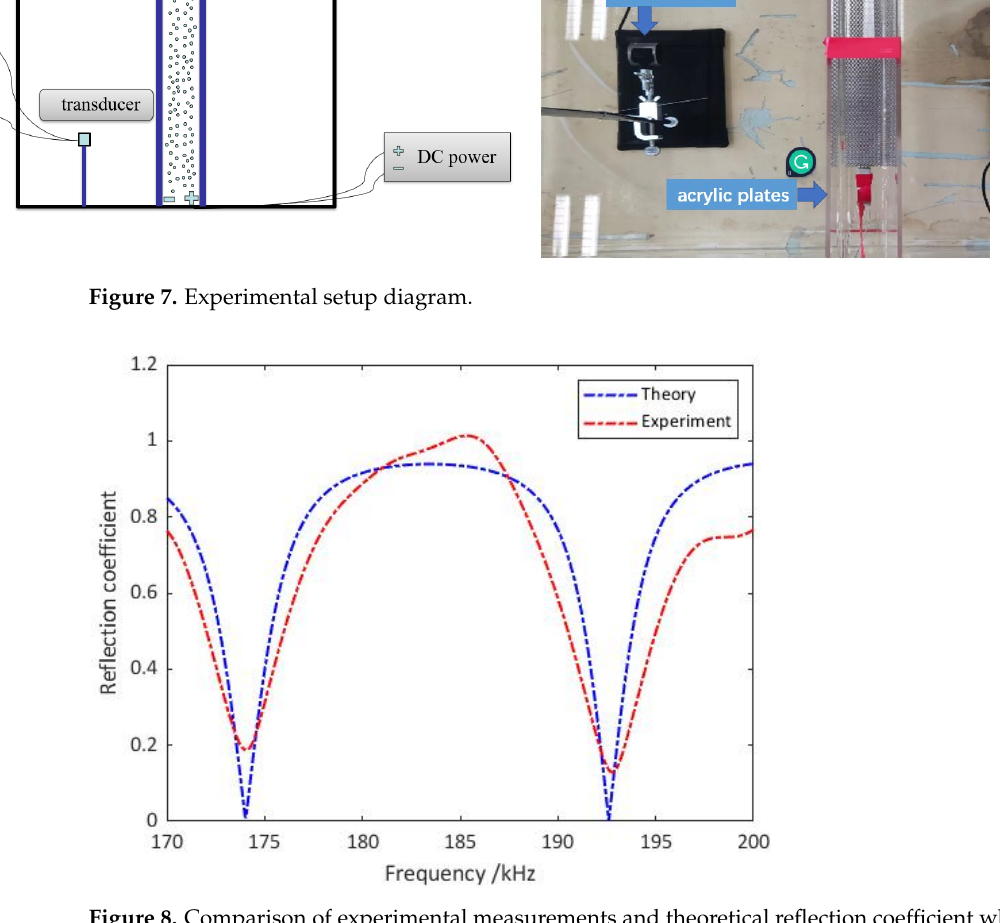
Figure 8. Comparison of experimental measurements and theoretical reflection coefficient when the middle layer is pure water.